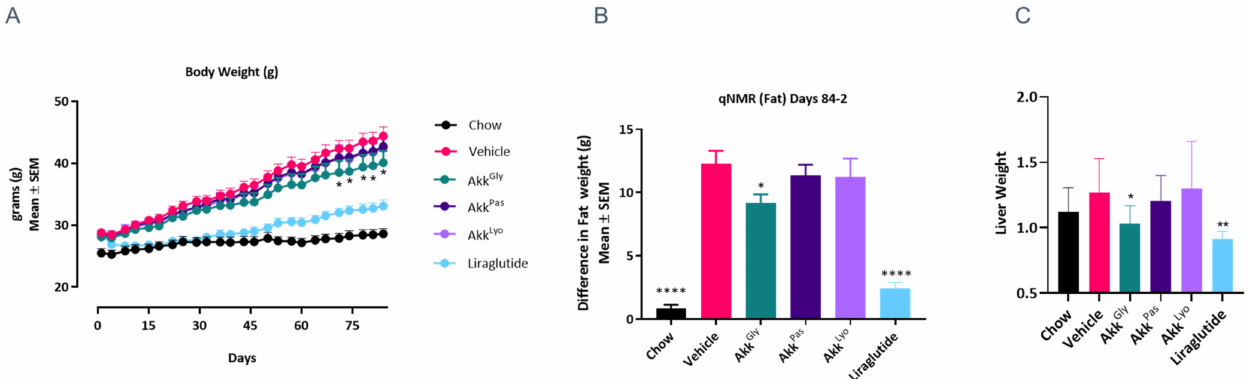
Figure 6. Akkermansia sp. DSM33449 negates weight increase and reduces fat accumulation in a DIO mouse model ( n = 10). ( A ) Growth curve of animals fed a standard chow (Chow) or high-fat diet (HFD) and treated by oral gavage with a solution of vehicle (PBS + Glycerol) or Akkermansia sp. DSM 33459 frozen (Akk Gly ) or pasteurized (Akk Pas ) or lyophilized (Akk Lyo ) for 12 weeks. ( B ) Difference in fat accumulation over the 12-week treatment period. ( C ) Difference in liver weight over the 12-week treatment period. Data are presented as mean ± SEM. *, p < 0.05; **, p < 0.01; ****, p < 0.0001, compared to